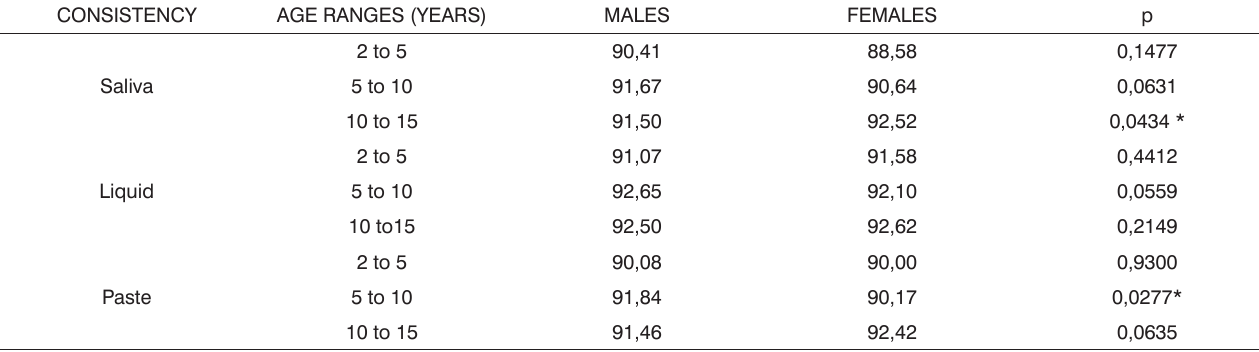
Table 5. Mean values and results from the swallowing time comparison test according to gender. CONSISTENCY